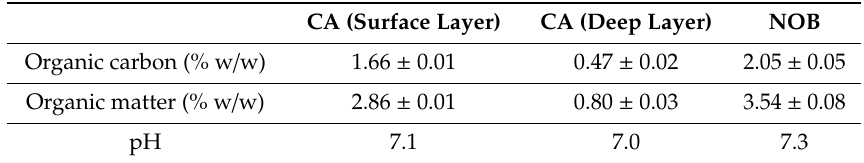
Table 2. General characteristics of the Turin central area (CA) and peripheral green area (NOB)